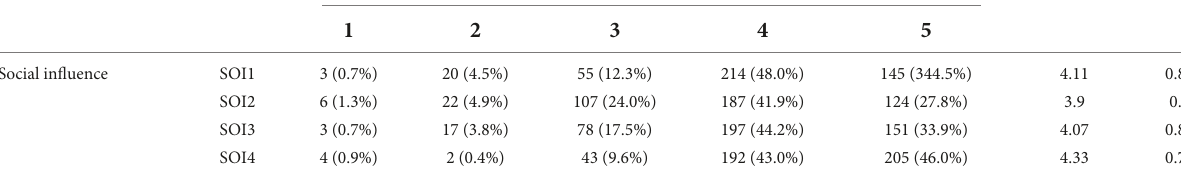
TABLE 8 Measuring perceived enjoyment (PE).